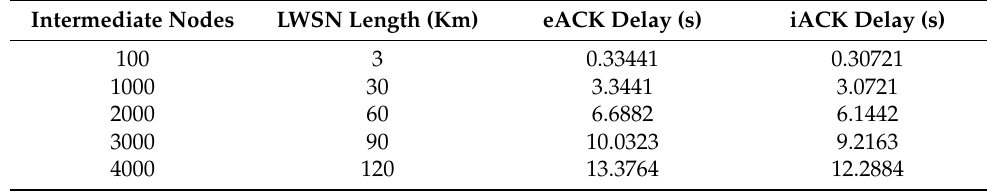
Table 3. Time for end-to-end transmission with 16 bits